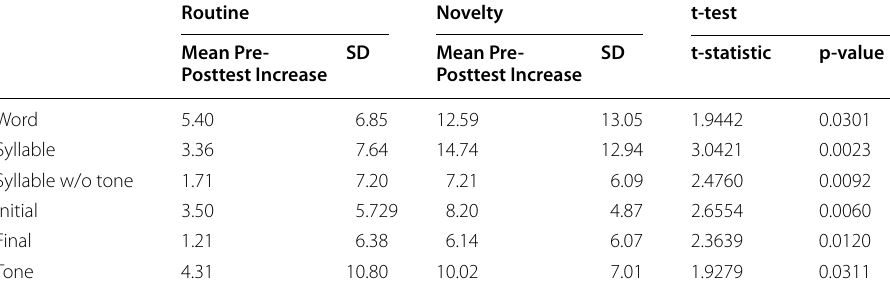
Table 3 Pretest–posttest improvements among intermediate learners Routine Novelty t-test Mean Pre- SD Mean Pre- SD Posttest Increase Posttest Increase